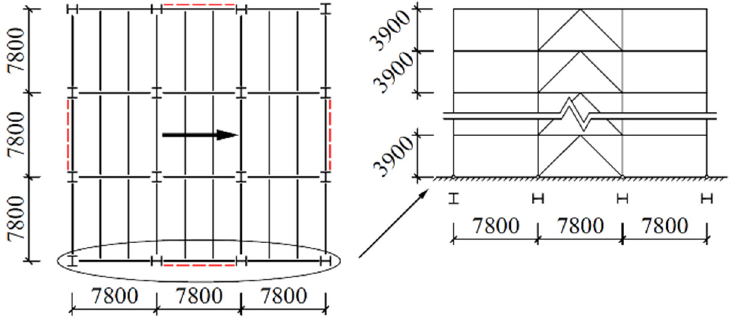
Figure 1. Plan view and elevation of CBF prototypes (unit: mm). Table 1. Design-member sizes of four-story prototype (unit: mm).